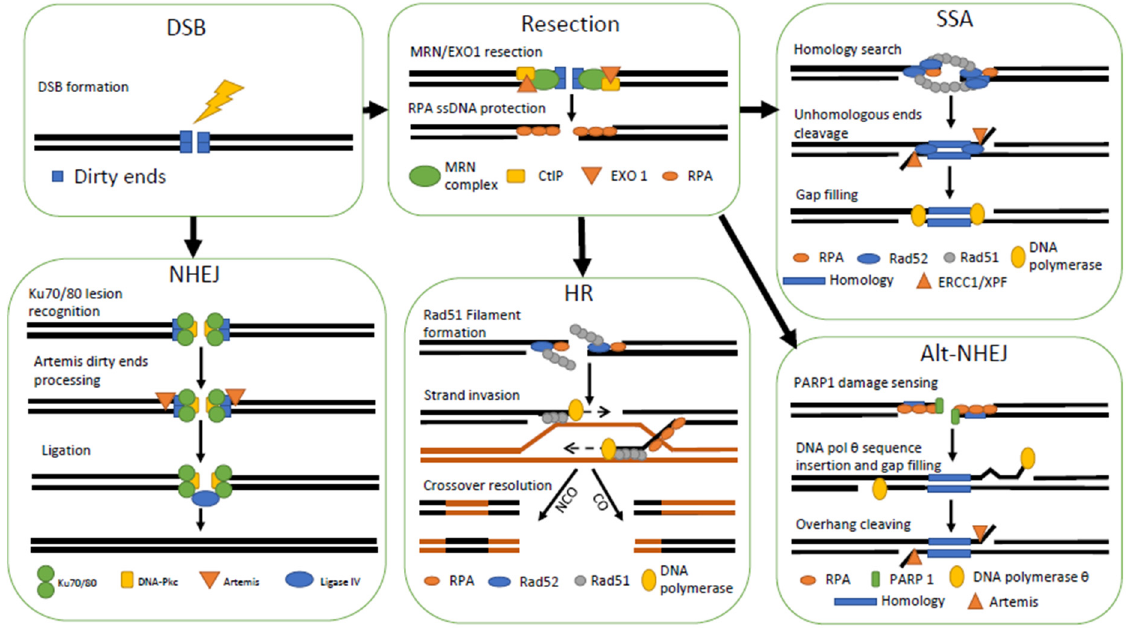
Figure 3. Double-Strand Breaks (DSBs) repair pathways. The repair of a DSB begins with DNA ends resection or direct ligation through Non-Homologous End-Joining (NHEJ). If resection does occur, Homologous Recombination (HR), Single Strand Annealing (SSA), and Alternative-NHEJ (Alt-NHEJ) compete to repair the DSB. NHEJ begins with Ku dimers binding to DNA ends and recruiting of DNA-Pkc. Artemis endonuclease is then recruited in order to clean dirty DNA ends, allowing the direct ligation by Ligase IV. Resection is carried out by exonuclease I (EXO1) but initiated by the MRN complex, assisted by CtIP. Single strand DNA is then protected by RPA. In HR, Rad52 will displace some RPA to allow the formation of Rad51 filament. Rad51 filament will find a homologous sequence and start strand invasion. DNA polymerase then fills gaps by using homologous chromatid as a template. Resolution of Holliday Junction leads to Chromosomal Exchange (CO) or Non-Chromosomal Exchange (NCO). SSA also uses Rad52 and Rad51, but the filaments target homologies surrounding the DSB. When hybridization occurs, unpaired 5 ′ overhangs are removed by ERCC1/XPF. Finally, polymerase fills the gap. Alt-NHEJ simply uses thermodynamics for annealing close to the DSB. Then DNA polymerase θ fills the gap.